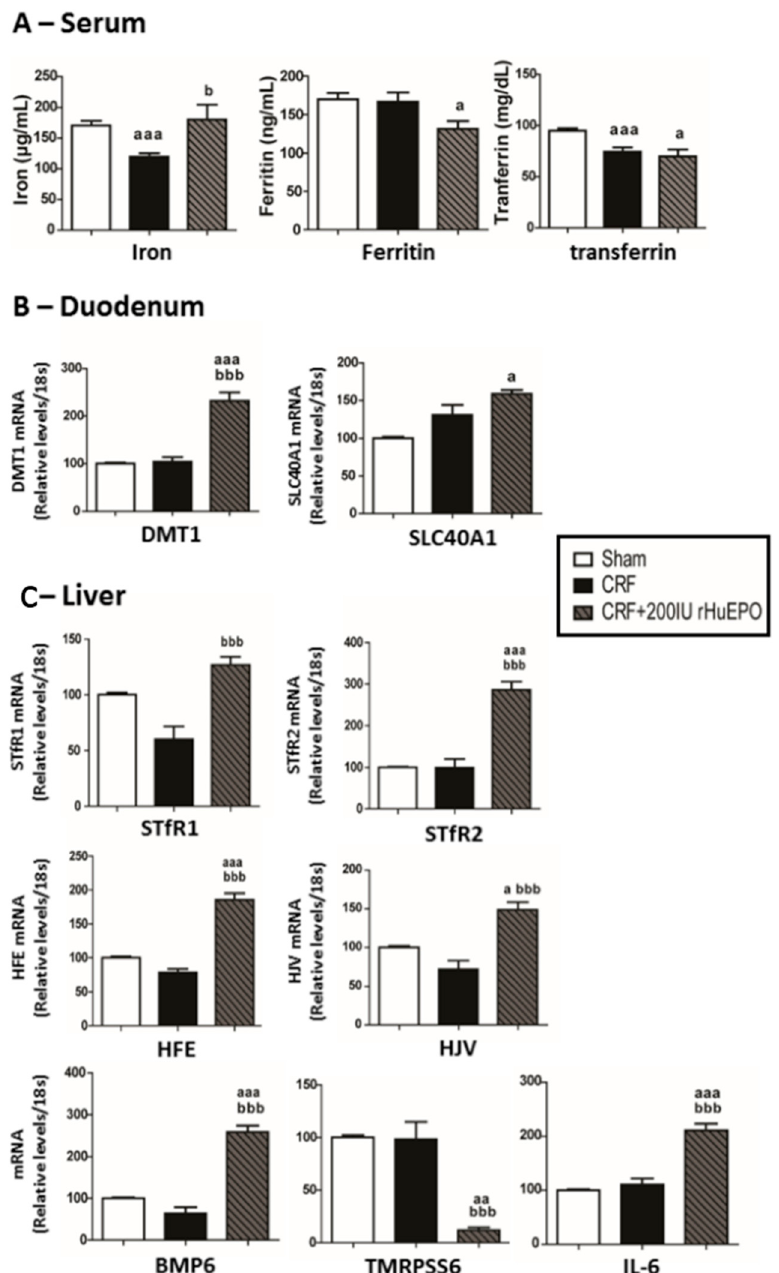
Figure 3. Iron metabolism: Serum iron, ferritin and transferrin at final time ( A ). Relative gene expression mRNA levels/18S of DMT1 and SLC40A1 in the duodenum ( B ) and of iron regulatory proteins in the liver ( C ) at the end of protocol (12 weeks). Results are presented as mean ± SEM (7 rats per group): a: p < 0.05; aa: p < 0.01; and aaa: p < 0.001 vs. Sham; b: p < 0.05; and bbb: p < 0.001 vs. CRF. Ferroportin ( SLC40A1 ), hemojuvelin ( HJV ), soluble transferrin receptor ( STFR ), hemochromatosis ( Hfe ), divalent metal transporter 1 ( DMT1 ), transferrin receptor 1 ( TfR1 ), matriptase-2 ( TMPRSS6 ), interleukin-6 ( IL-6 ) and bone morphogenic protein 6 ( BMP6 ).